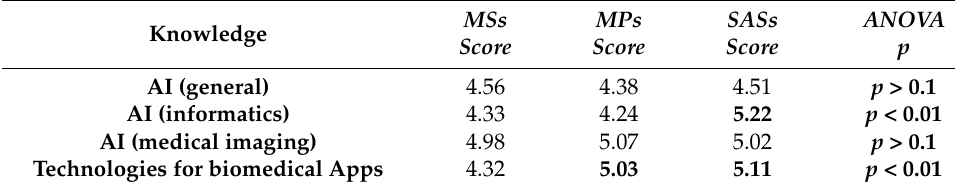
Table 2. Specific outcome of the perceived training.